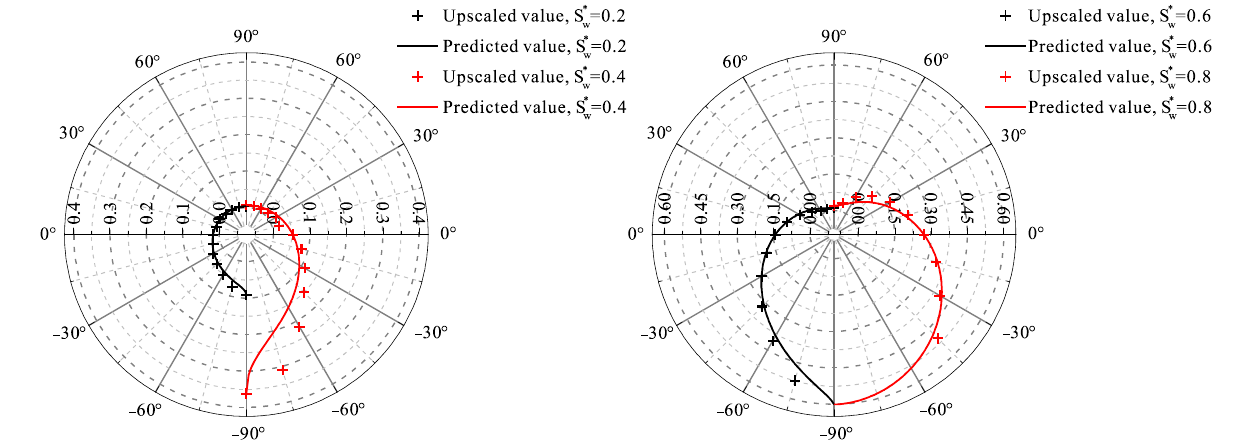
Figure 20. Comparison of water phase relative permeability of the single-vug model obtained via the upscaling method and predicted by the proposed directional relative permeability model.